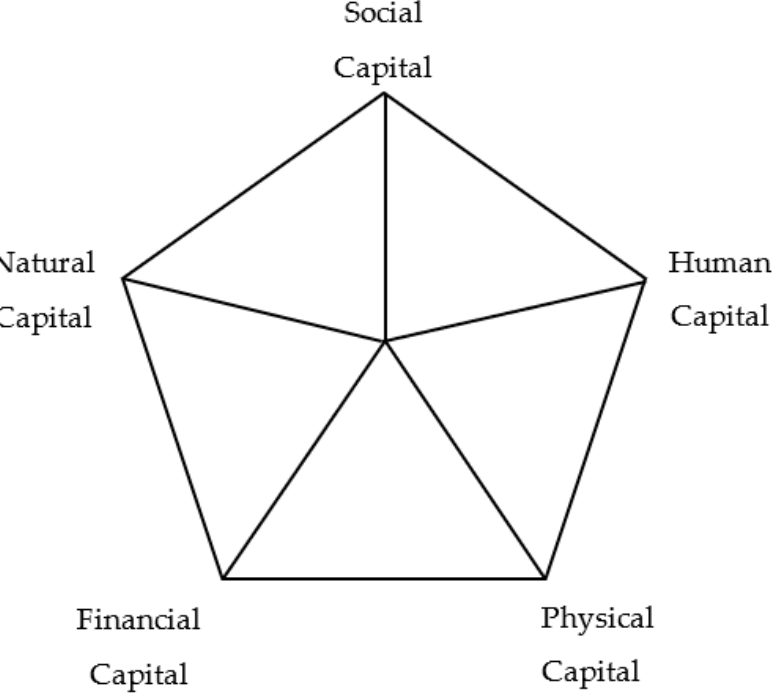
Figure 1. Dimensions, with sustainable livelihood capitals.